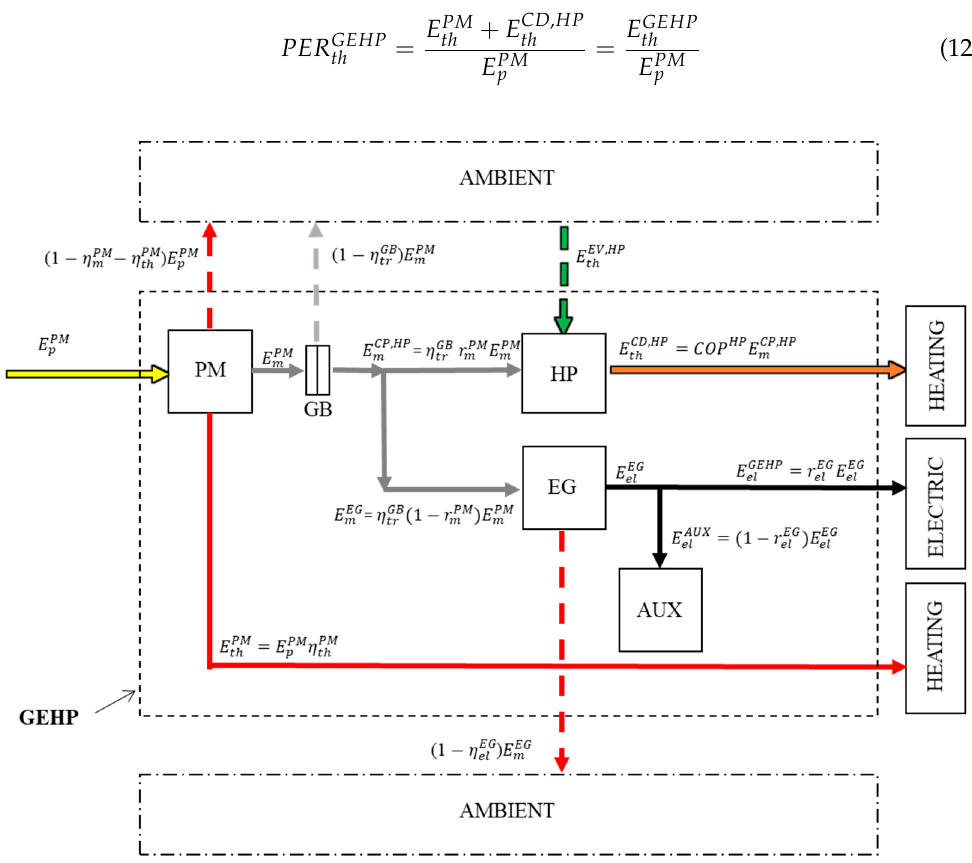
Figure 13. GEHP with EG in heating